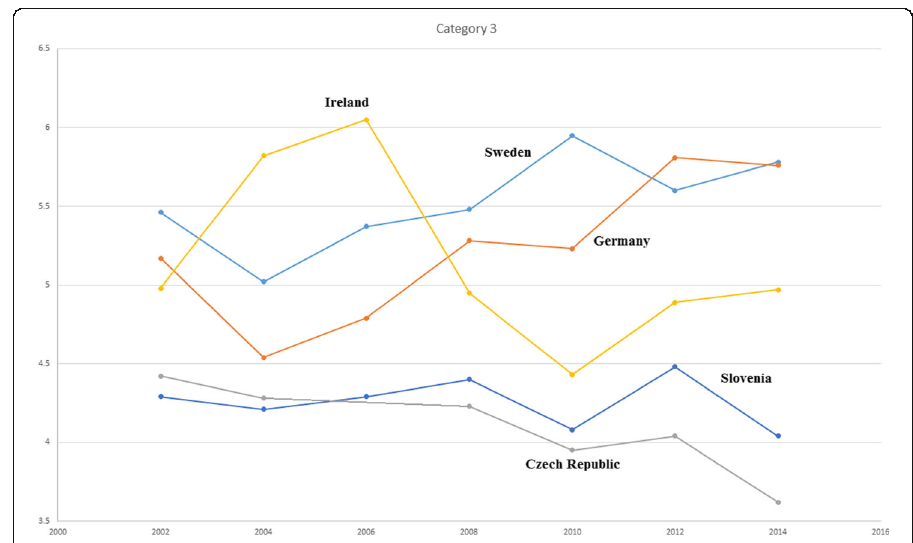
Fig. 4 Immigration good or bad for the economy (1 – 10) (Source: ESS round 1 – 7 (2002 –